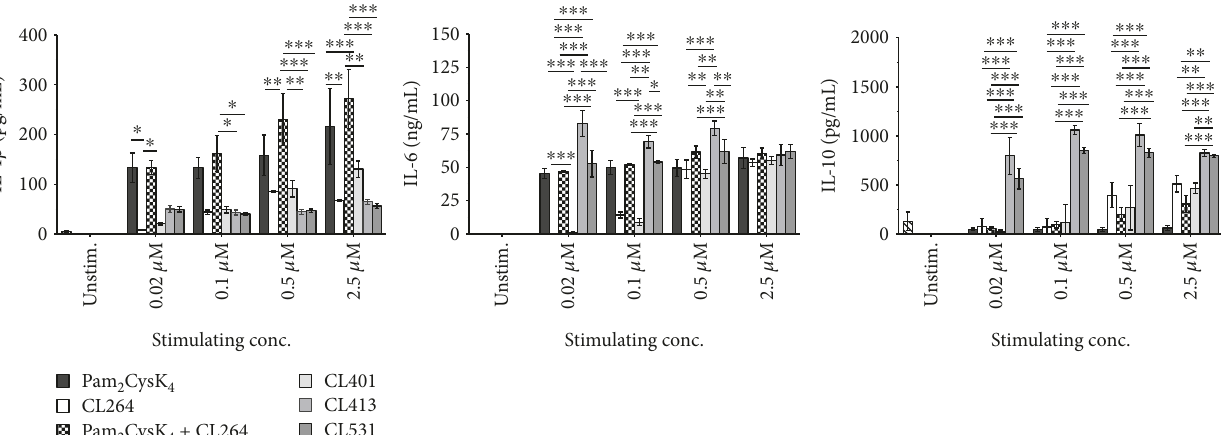
Figure 1: The dual TLR2/7 ligands CL413 and CL531 induce a strong BMmDC IL-10 secretion. Cytokine secretion from stimulated BALB/c BMmDCs. Data are mean results of three independent experiments ± SD. ∗ P < 0 05 ; ∗∗ P < 0 01 ; ∗∗∗ P < 0 001 . 0.01.02.03.04.05.06.0